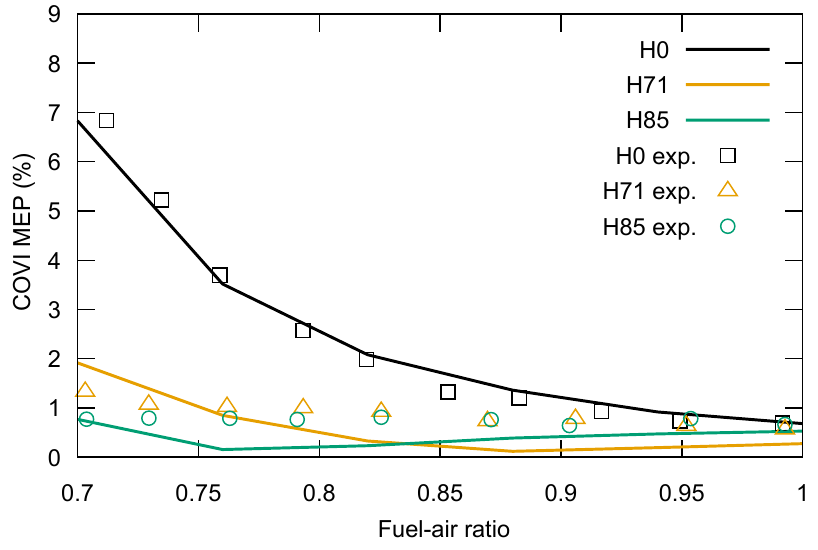
Figure 1. Simulated coefficient of variation (COV) of indicated mean of effective pressure (IMEP) after 10 4 cycles (lines) and comparison with the experimental results of Ji et al. [56] (symbols). Three concentrations of hydrogen by volume are considered: H0 (pure isooctane), H71 (71% H 2 by total fuel volume), and H85 (85%). Details can be checked in [31].